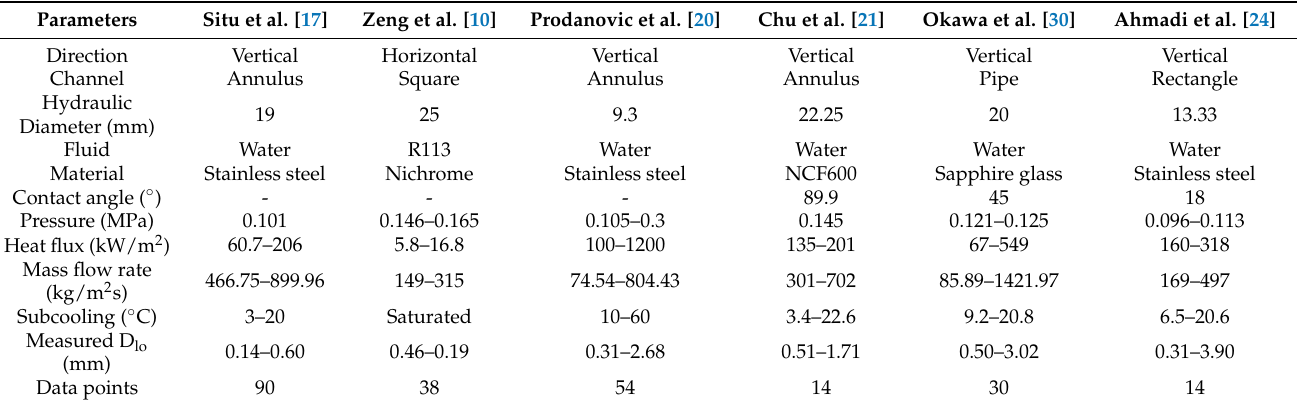
Table 2. Detailed experimental